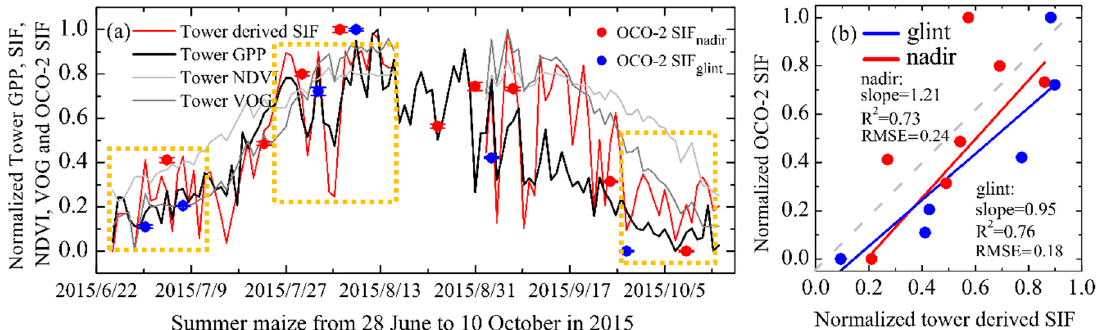
Figure 2. The consistency of OCO-2 SIF in Glint and Nadir observation modes with the tower derived SIF: ( a ) Seasonal dynamics of tower gross primary production (GPP), normalized difference vegetation index (NDVI BRDF ), Vogelmann red edge index (VOG BRDF ), tower sun-induced chlorophyll inflorescence (SIF), and OCO-2 SIF; ( b ) the relationship between OCO-2 SIF in Glint and Nadir modes and the tower SIF at the CN-YuC site over the 2015 growth period of summer maize. There are only six data points on Glint mode and seven data points on Nadir mode for both satellite overpassing and tower observing at the same time. The missing observations from 17 August 2015 to 1 September 2015 were due to an equipment failure.